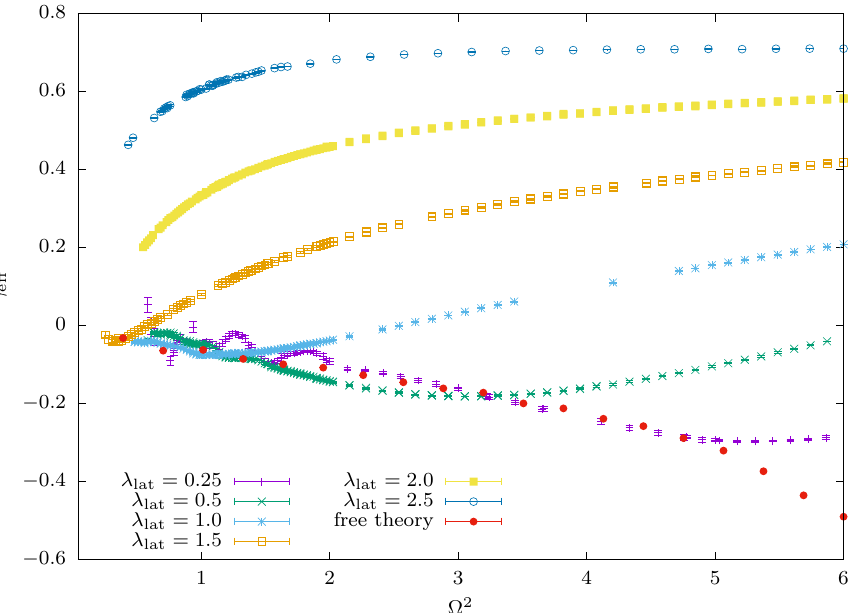
Figure 8. Effective anomalous dimension γ eff obtained from using eq. (3.3) to fit the stochastic Chebyshev mode number across windows [Ω 2 , Ω 2 + ‘ ] with Ω 2 ≥ 0 . 1 and a fixed length 0 . 03 ≤ ‘ ≤ 1 for each 16 4 ensemble with gauge group U(2). We again include free-theory results (for ‘ = 1 , cf. figure 2), and now omit results from any fits that produce a correlated χ 2 / d.o.f. > 10 .